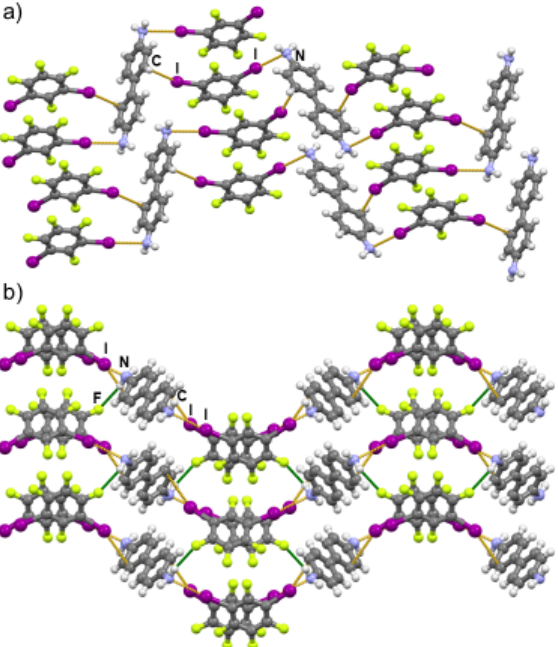
Figure 4. ( a ) Layers formed by linking bnzd and 13tfib molecules via I ··· NH 2 and I · · · C π halogen bonds (yellow) in the structure of ( otol )( 14tfib ); ( b ) layers connected through N–H · · · F hydrogen bonds (green) into a 3D structure.